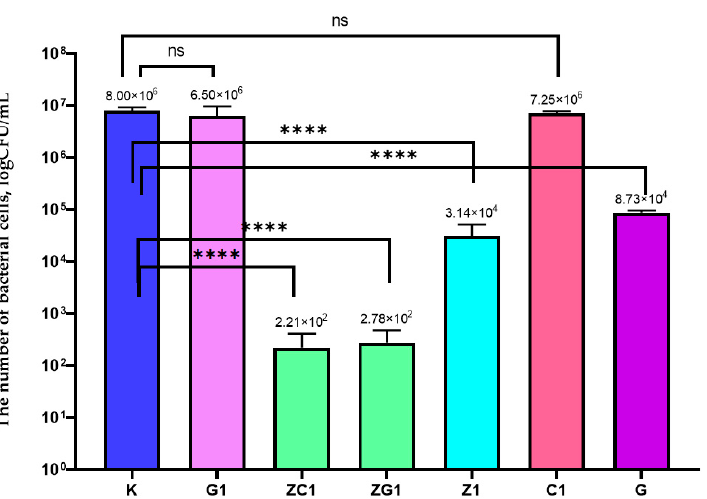
Figure 3. The influence of coatings on P . syringae growth. K–PE film; G1–PE film covered with the MHPC coating containing 0.0125 g of geraniol in 100 mL carrier; C1–PE film covered with the MHPC coating containing 0.0125 g of carvacrol in 100 mL carrier; G–PE film covered with the MHPC coating containing 5 g of geraniol in 100 mL carrier; Z1–PE film covered with the MHPC coating containing 0.041 g ZnO nanoparticles in 100 mL carrier; ZG1–PE film covered with the MHPC coating containing 0.041 g ZnO nanoparticles and 0.0125 g of geraniol in 100 mL carrier; ZC1–PE film covered with the MHPC coating containing 0.041g ZnO nanoparticles and 0.0125 g of carvacrol in 100 mL carrier, one-way ANOVA: ns—not significant; *— p < 0.05; **— p < 0.01; ***— p < 0.001; ****— p < −